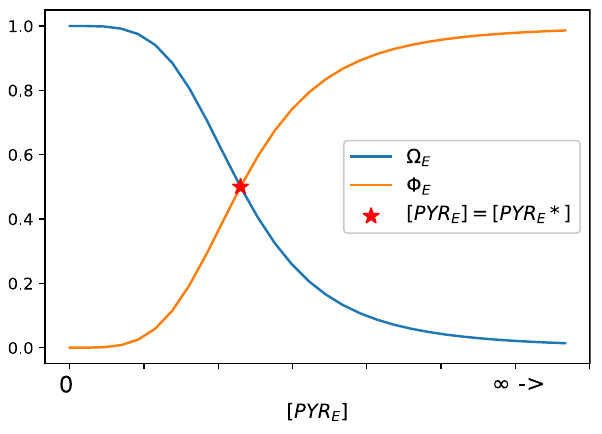
PYR E ∗] 4 Figure 3. The regulating function (cid:31) E = [ (blue line), and its complement � E = ( 1 − � E ) [ PYR E ∗] 4 +[ PYR E ] 4 (orange line) take values between 0 and 1 depending on the concentration of [PYR E ] with respect to the constant [PYR E *]. This parameter represents the healthy RPE’s requirement of pyruvate, and determines the proportion of glucose that the RPE keeps for its own glycolysis pathway, and the proportion that it is diverted to the rods. For low (cid:31) E (high (cid:31) E ), the RPE’s glucose utilization is blocked (and redirection of glucose to the photoreceptors is favored). Conversely, high (cid:31) E (low (cid:31) E ) favors the RPE’s retention of glucose, activating